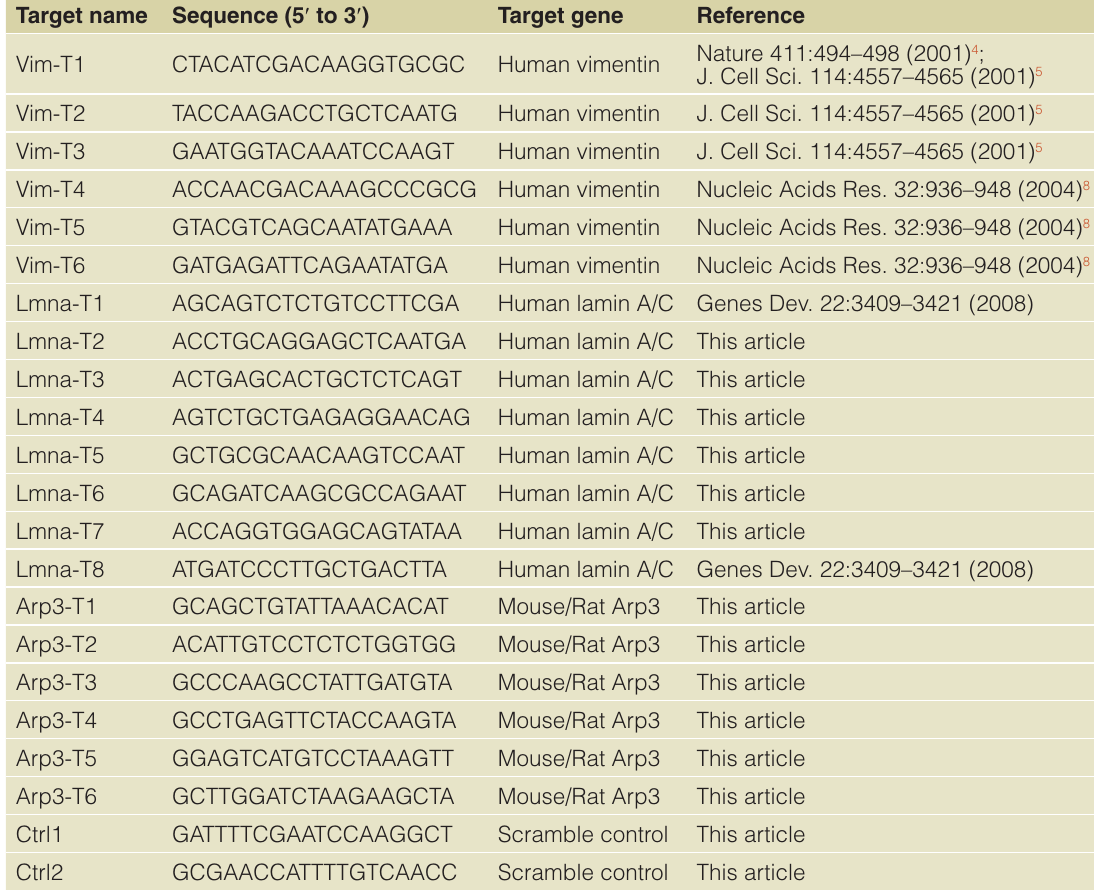
Table 1. Target sequences for shRNA validation in this